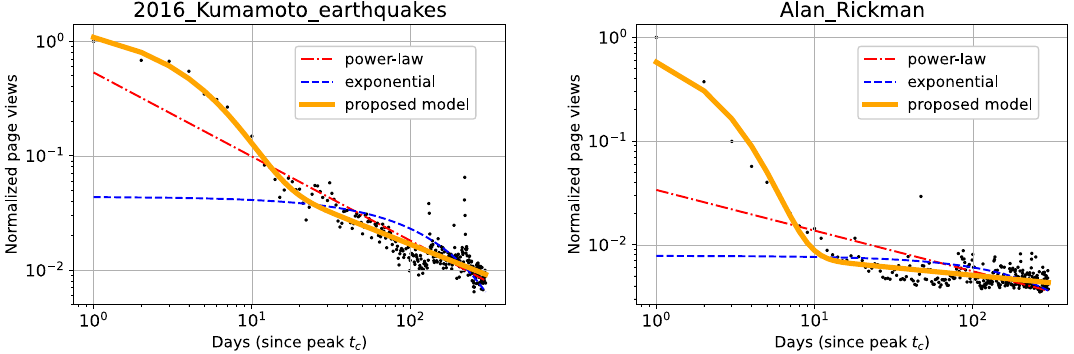
Figure 3. Fitting examples shown in Fig. 1 of the proposed two-phase model for 300 days. Blue dashed line and red dash-dotted line correspond to the simple exponential decay and power-law decay, respectively. Yellow solid line shows the proposed two-phase model which combined the exponential and power-law functions.